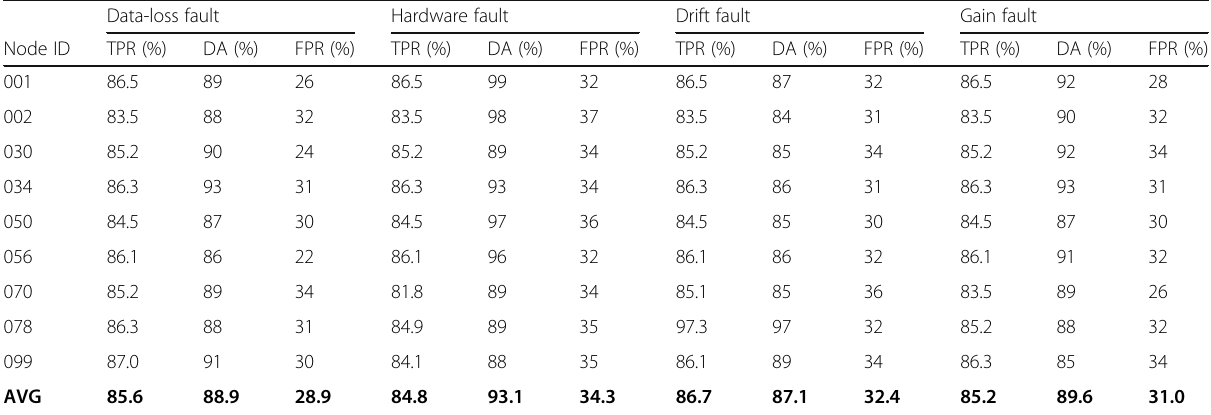
Table 2 Summary of the effects of training accuracy of different fault types Data-loss fault